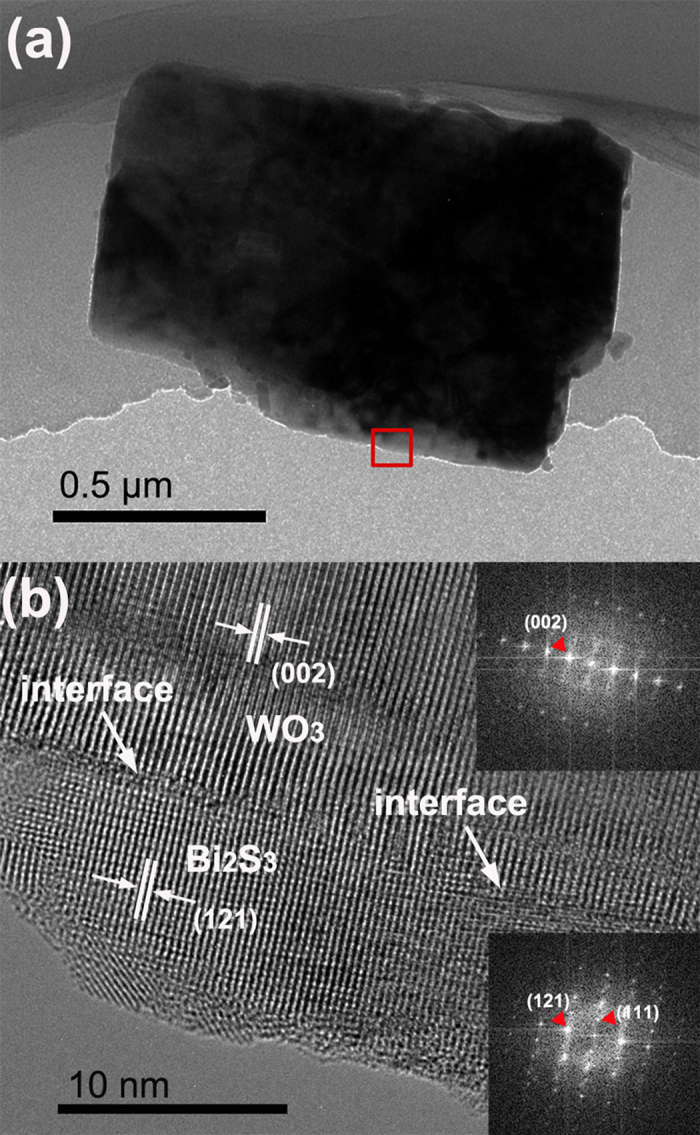
(a) TEM image of a Bi2S3/WO3 plate, (b) HRTEM image of the interface between Bi2S3 and WO3.